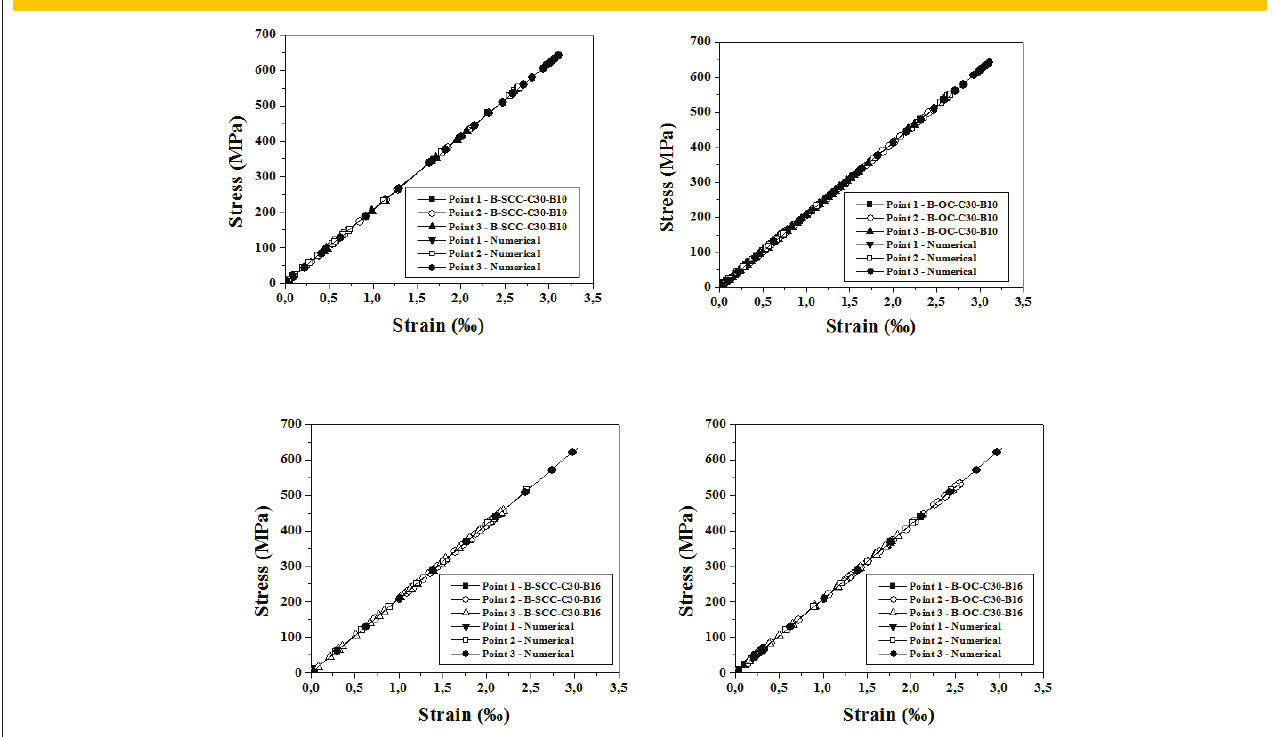
Figure 14 – Comparison between the test results from the strain gages and the numerical result